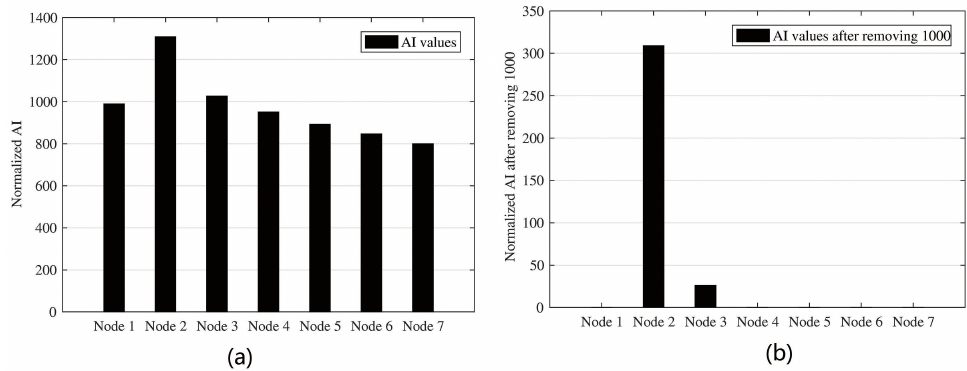
Figure 16. Distribution of normalized AI along the bridge ( a ) for the node N2D7-7 and ( b ) after subtracting 1000 from the N2D7-7